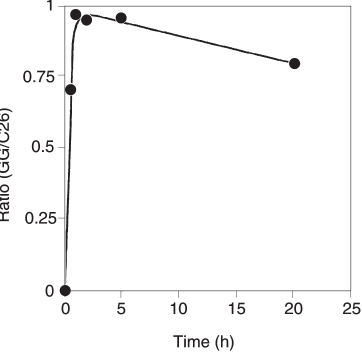
Figure 3. A positive ion EI-MS spec- trum of the hydrocarbon product pre- pared by LiAlH 4 reductive cleavage of di- O -geranylgeranyl- sn -glycerol-1- phosphate (unsaturated archaetidic acid). The hydrocarbon product was separated by GLC and the 3.0 min peak on the chromatogram shown in Figure 2 was subjected to MS. The lower part of the figure shows a possi- ble fragmentation pattern of the hydro- carbon, which coincides well with the mass spectrum.